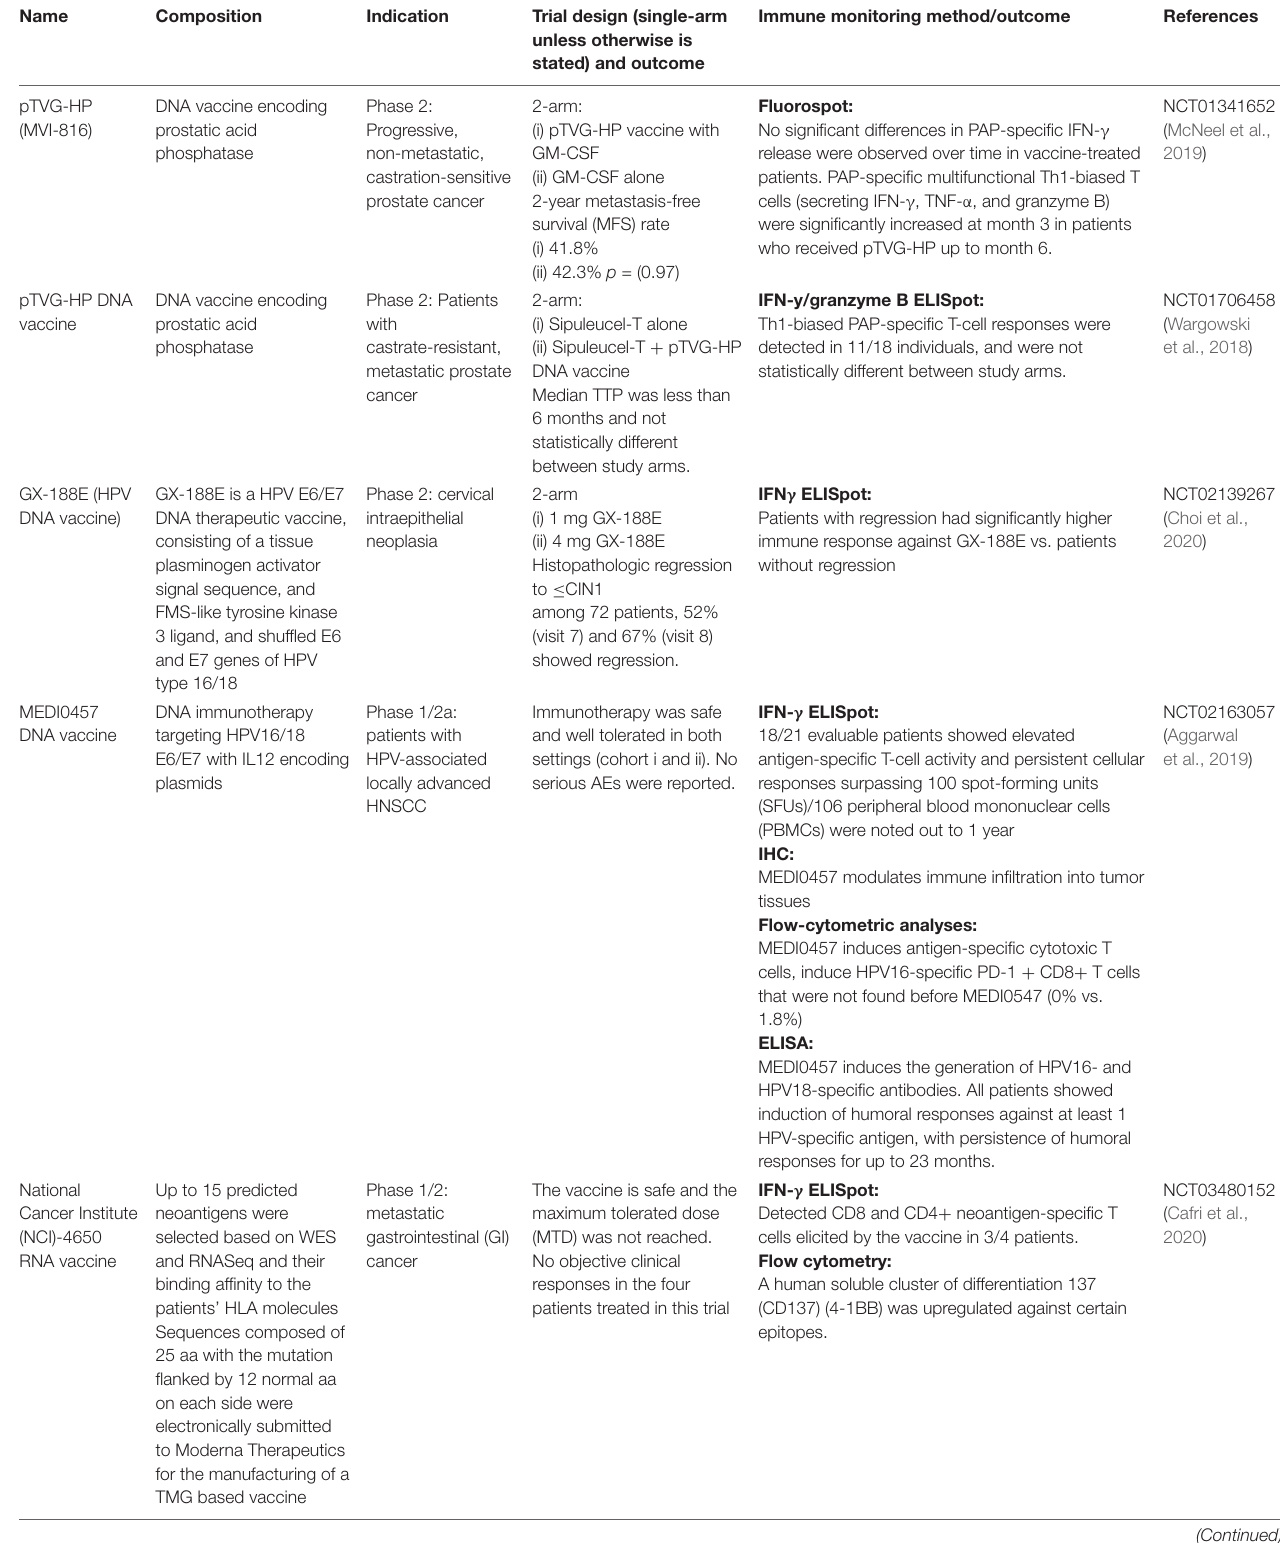
TABLE 2 | DNA/RNA/peptide-related cancer